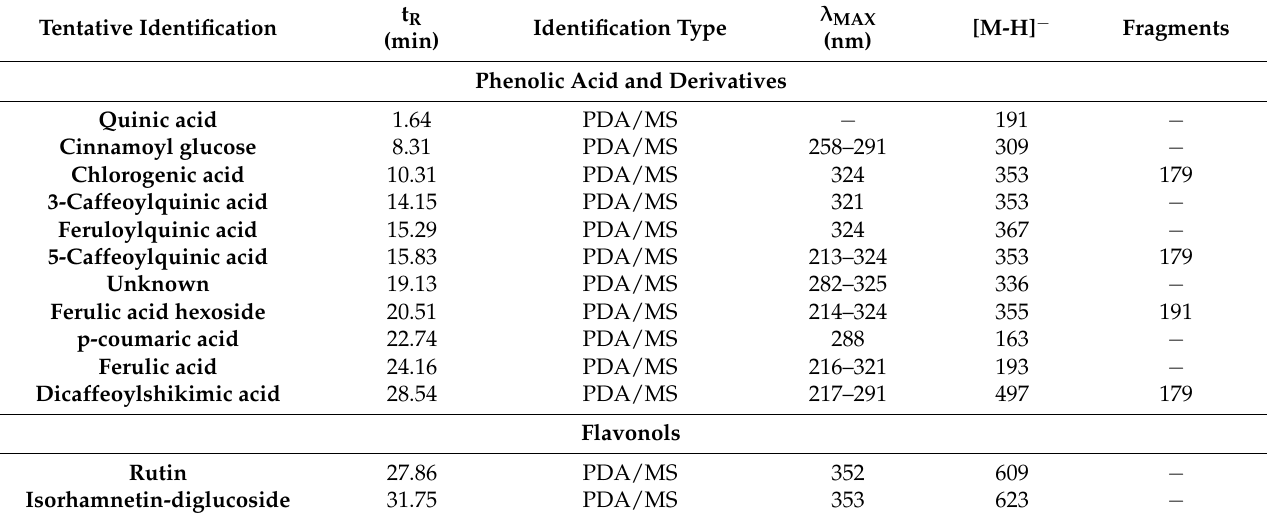
Table 6. Polyphenolic compounds detected in MeOH-H 2 O extract of C. humilis by